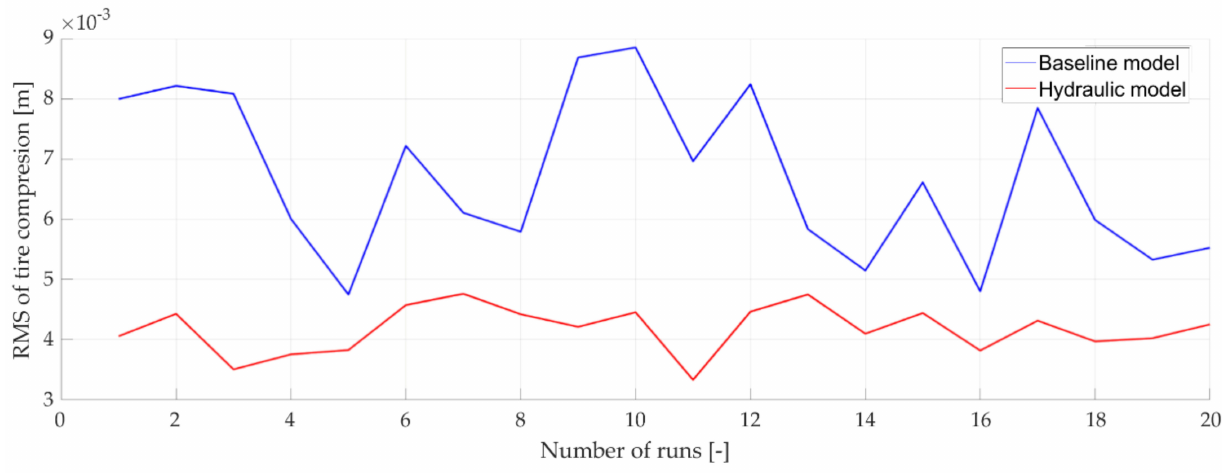
Figure 18. The root means square of the front left wheel vertical motion relative to the